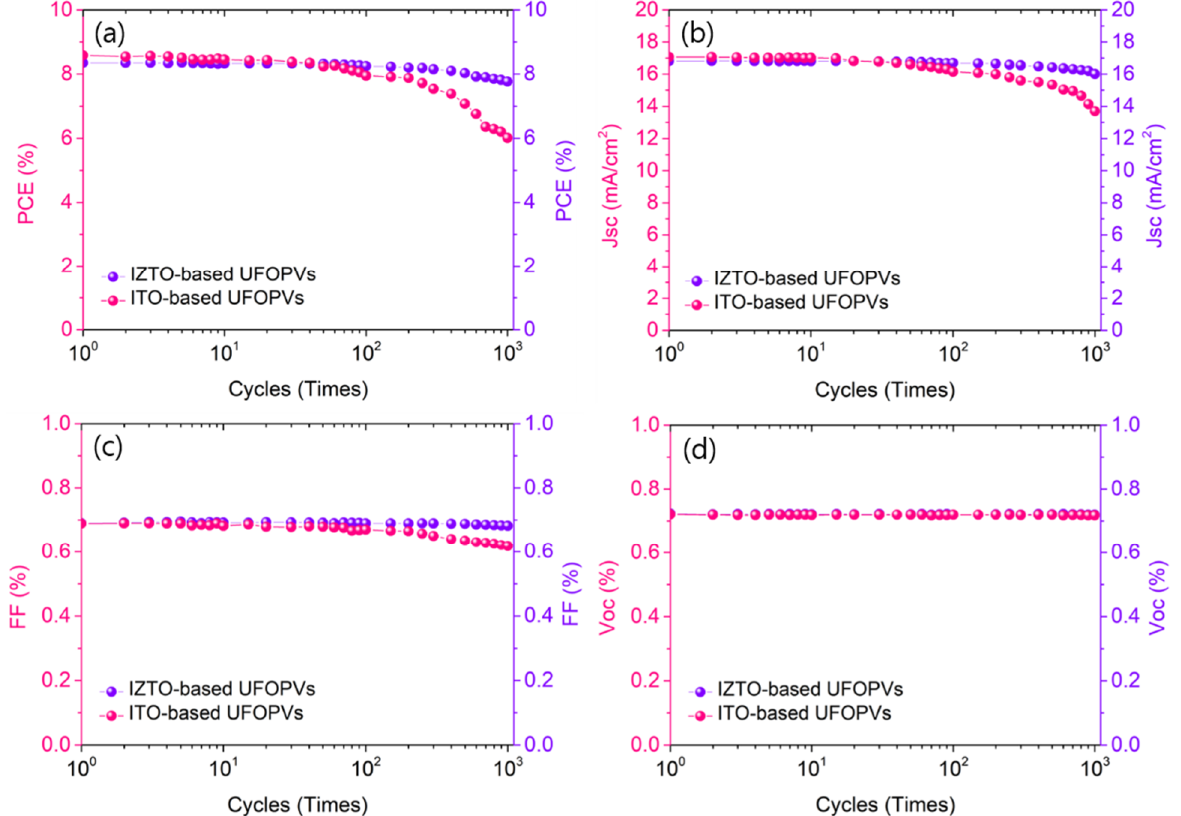
Figure 6. Behavior of photovoltaic parameters under cyclic compression of ultra-flexible OPVs with ITO, and ultra-flexible OPVs with IZTO: ( a ) PCE, ( b ) J SC, ( c ) FF, and ( d ) Voc. Table 2. Device characteristics of various device structures after mechanical test.